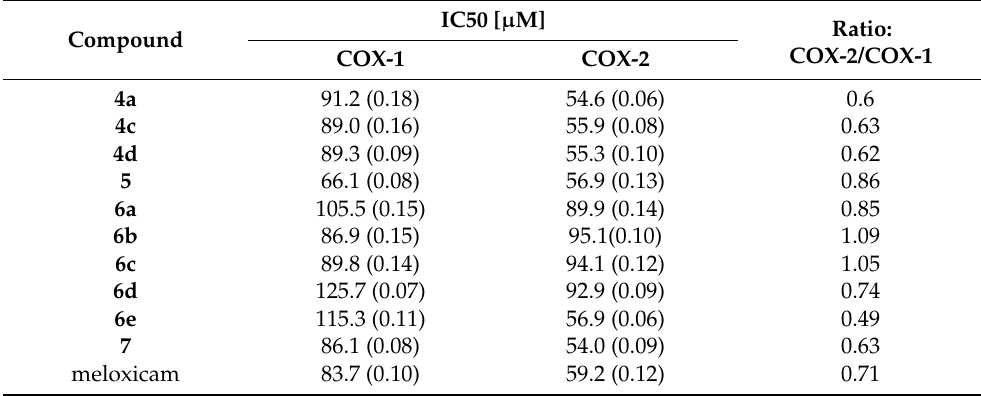
Table 2. IC 50 values calculated for COX-1 and COX-2 enzymes after incubation for 2 min with